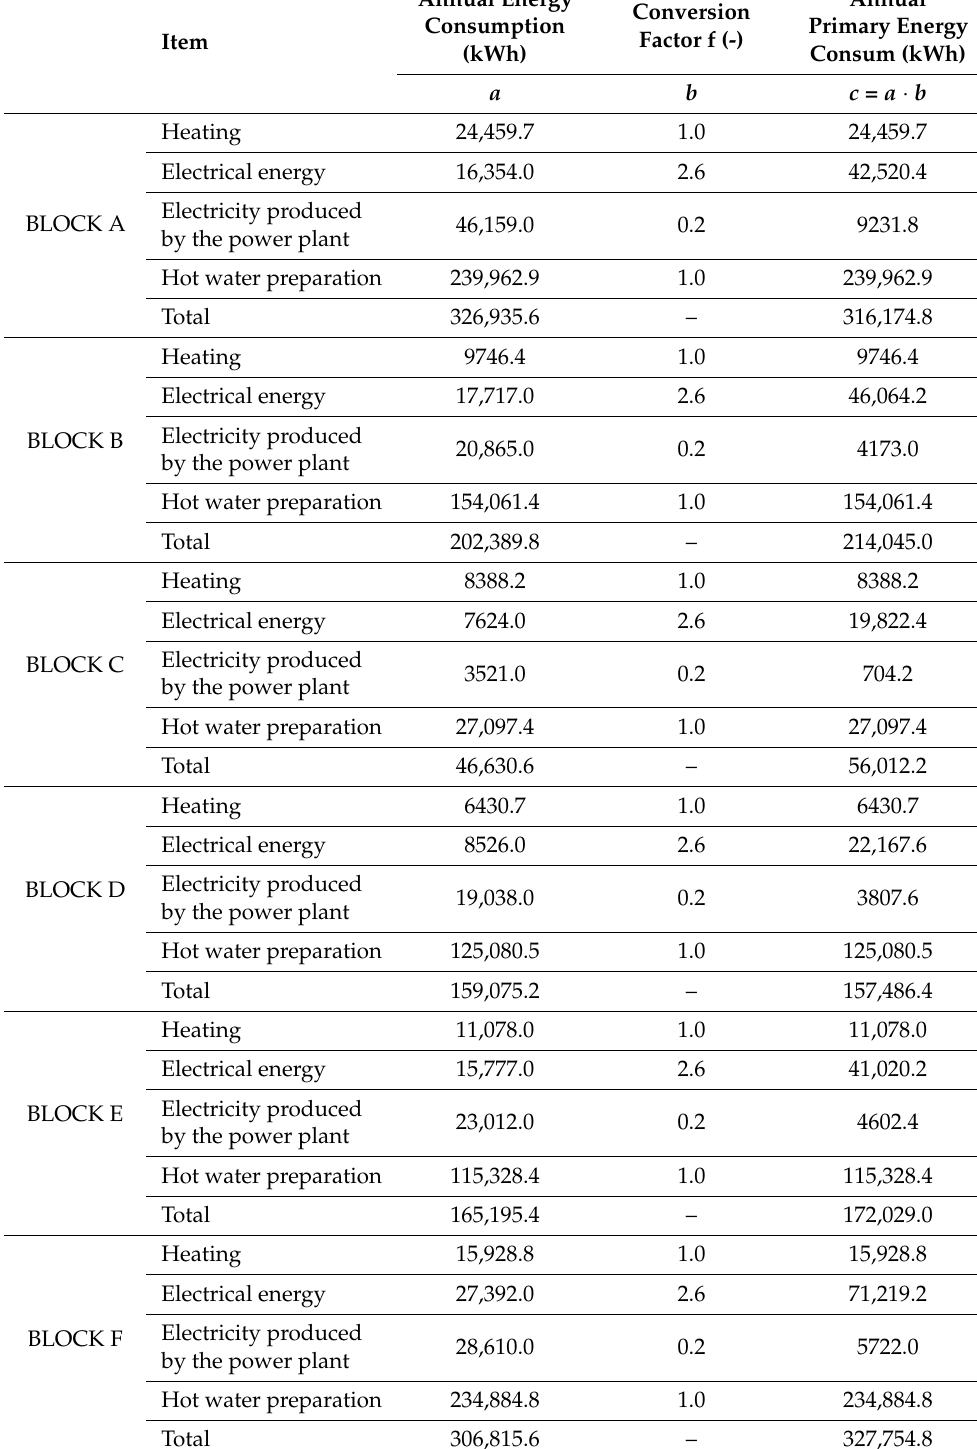
Table 14. Primary energy consumption values for the state after